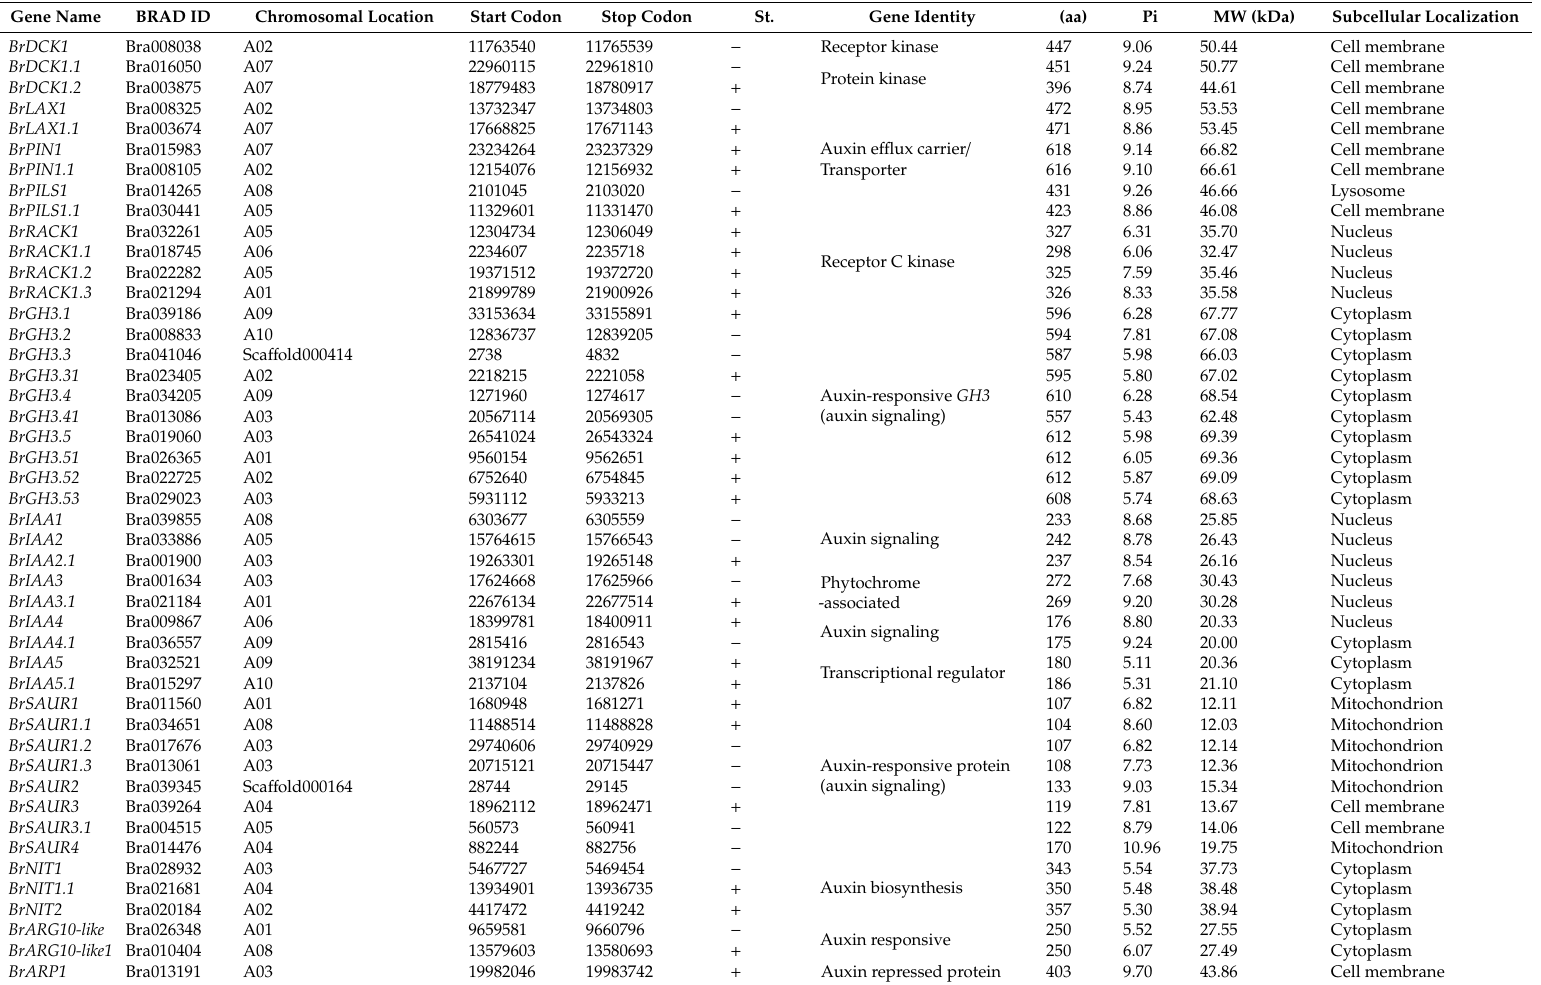
Table 1. Properties of genes involved in auxin metabolism, signaling, and transport in Brassica rapa. St., strand; aa, amino acid; Pi, isoelectric point, MW,